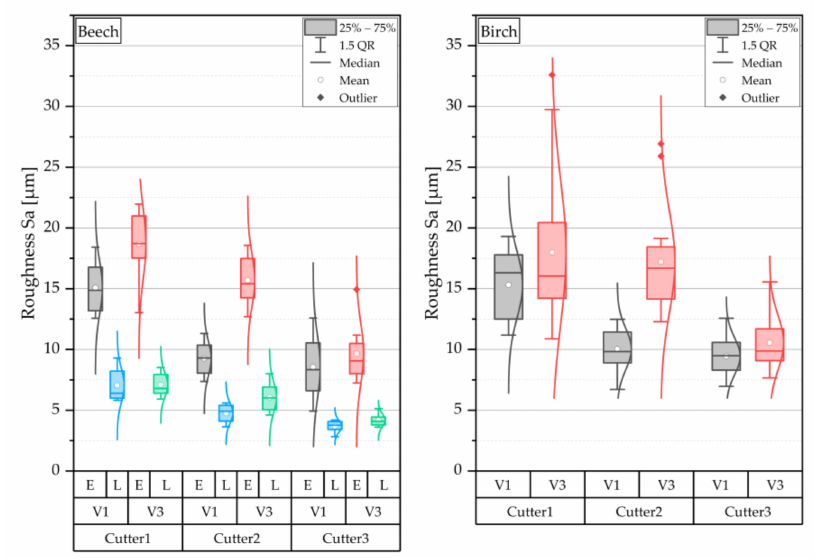
Figure 10. Effects on roughness and differentiation of the roughness of beech early (E)- and latewood